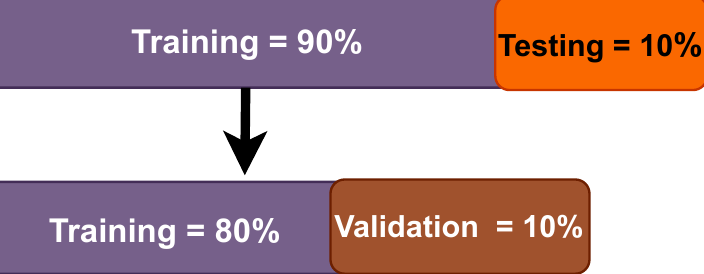
Figure 7. Illustration of the training, validation, and testing structures employed in this